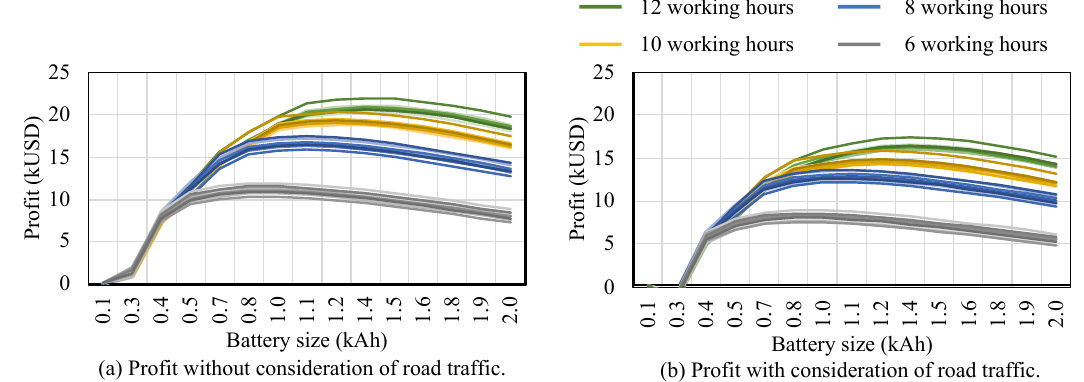
Figure 10. Profit comparison by delivery working hour when ( a ) we do not consider road traffic and ( b ) we do consider road